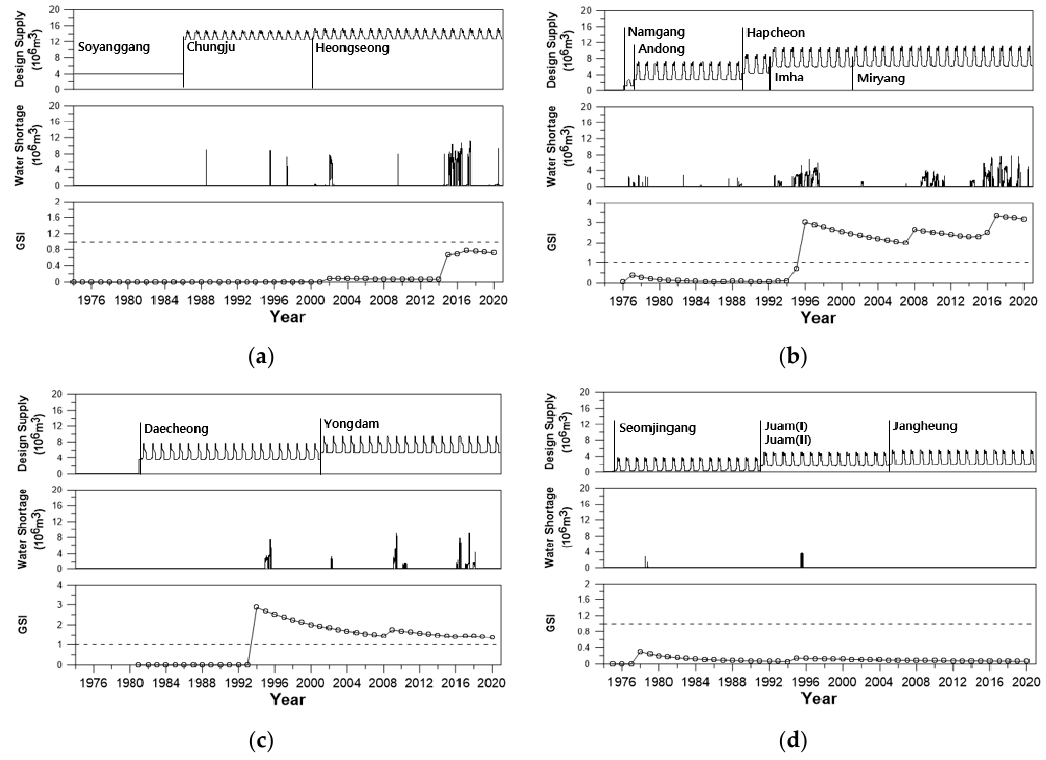
Figure 9. Estimation results of GSI for major river basins in Korea: ( a ) Han River Basin, ( b ) Nakdong River Basin, ( c ) Geum River Basin, and ( d ) Seomjin River Basin. Juam (I) and Juam (II) correspond to the Juam Dam and the Juam Controlled Dam, respectively.